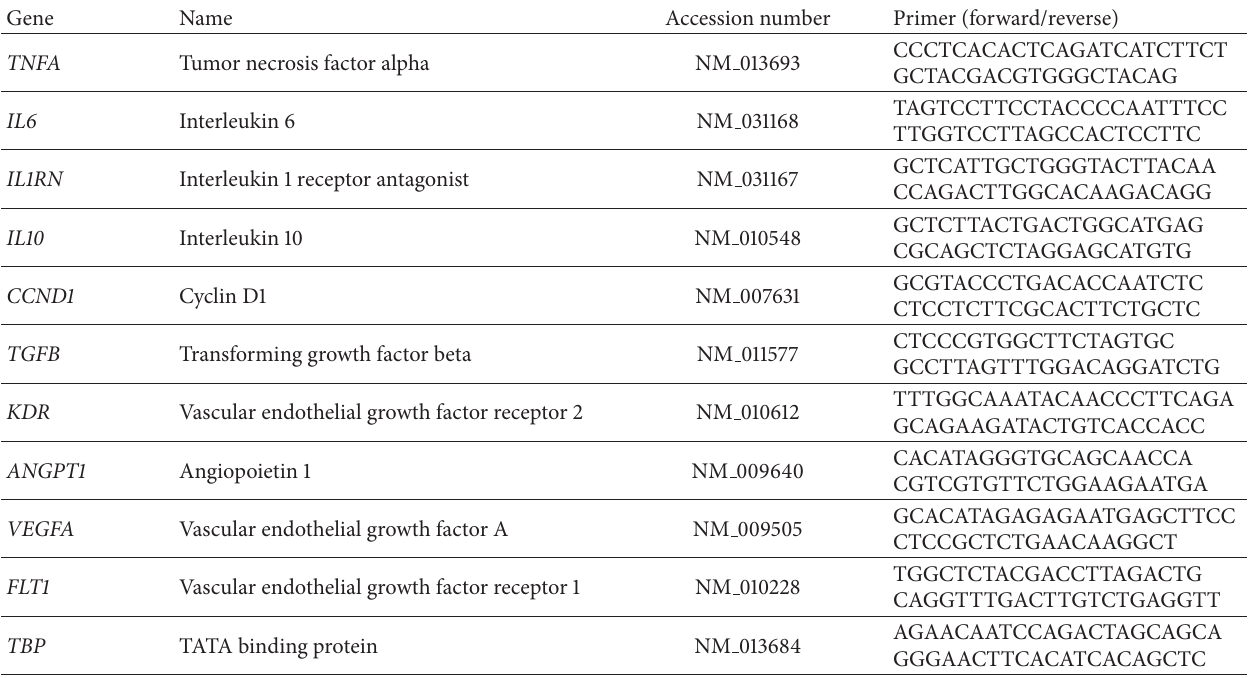
Table 1: RT-PCR primer